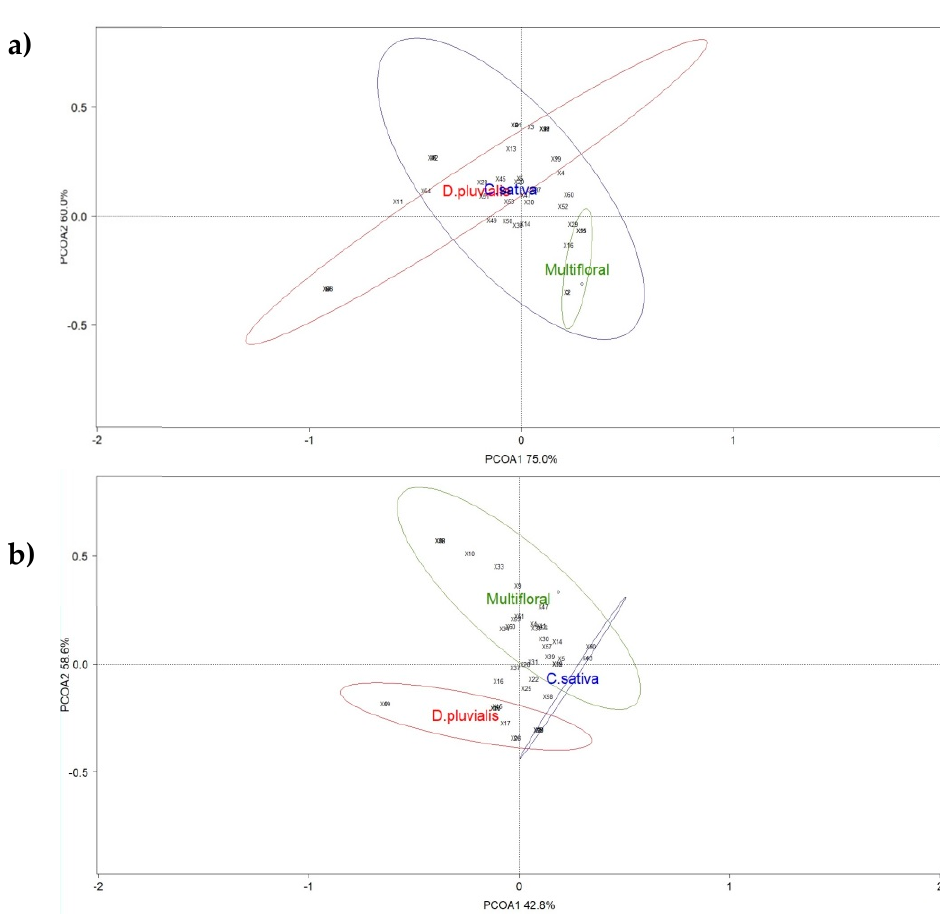
and N = 2 (right panel). The 95% confidence intervals (coloured-shaded regions) were obtained by a ANOSIM show no significant dissimilarities in the pollinator communities in the pan traps bootstrap method based on 100 replications. (global R = − 0.037; p -value = 0.606) (Figure 4a). As for the communities captured with the net during transects, the species distribution differed between the three treatments (global R = 0.794; p -value = 0.003) (Figure 4b).